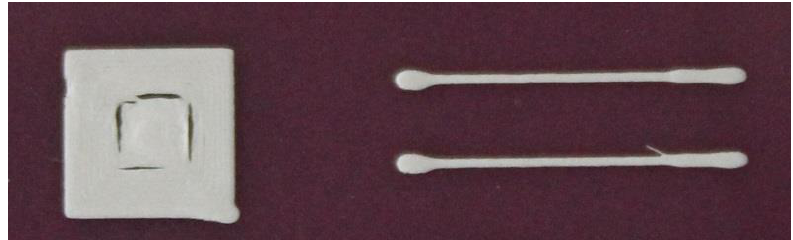
Fig. 10. Dependence of the separation force on the annealing temperature of samples.